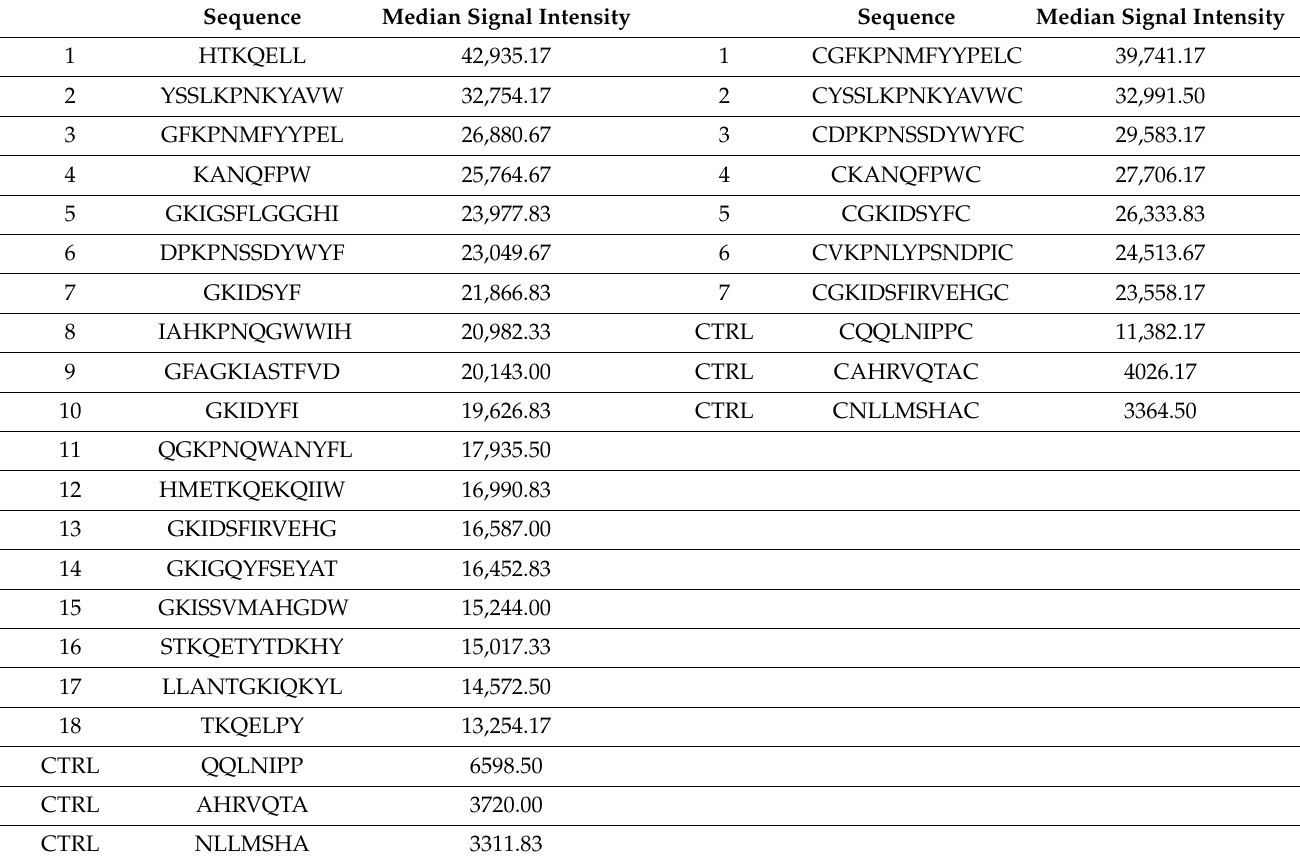
Table 3. Peptides studied by microarray with the signal intensity twice as high as the strongest negative control. Left: linear peptides, right: cyclized